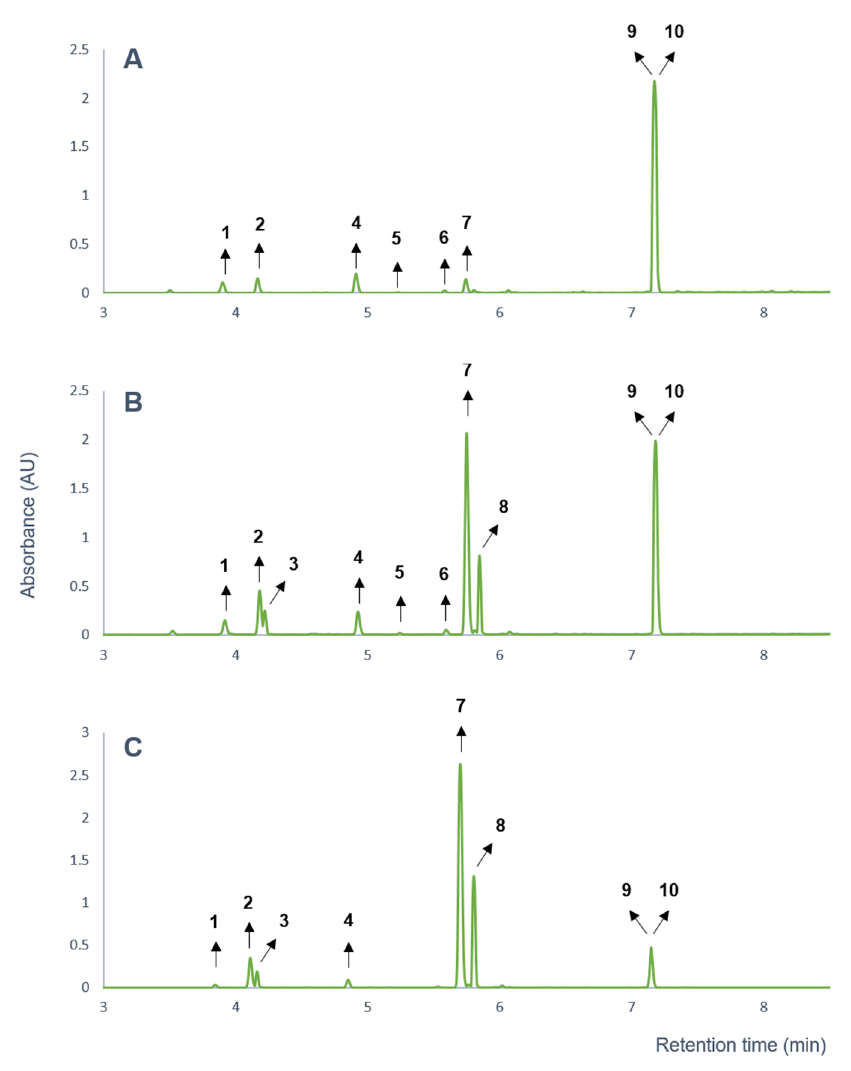
Figure 1. UPLC-DAD chromatograms of A. galanga ( A ) ethyl acetate extract (10 mM, prepared with DMSO), ( B ) PAMPA-GI stock solution (ethyl acetate extract diluted with PBS) after 4 h of incubation, and ( C ) PAMPA-GI acceptor side after 4 h of incubation.